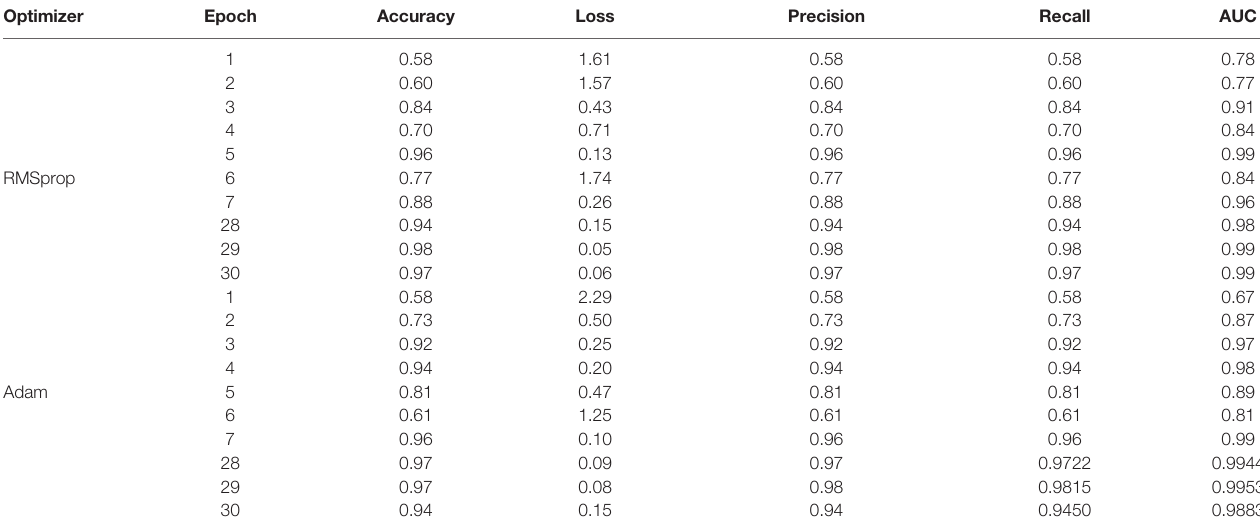
TABLE 1 | Results obtained on the Validation dataset using two optimizers: RMSprop and Adam. Optimizer Epoch Accuracy Loss Precision Recall AUC 1